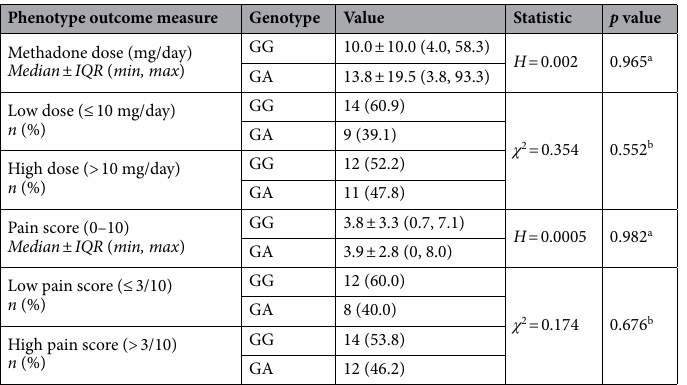
Table 2. Methadone dose and pain score for each genotype. a p > 0.05 as determined by Kruskal–Wallis H test or b Chi-squared test for association of methadone dose or pain score with genotype GG (n = 26) compared to GA (n =